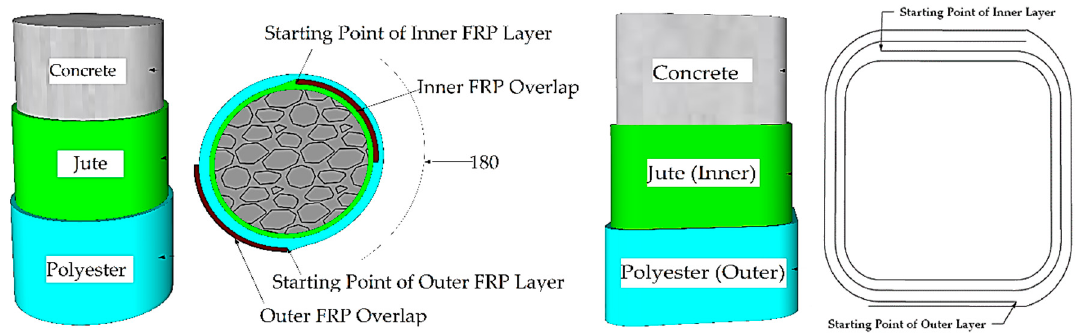
Figure 6. Circular and square fiber wrapping configuration.